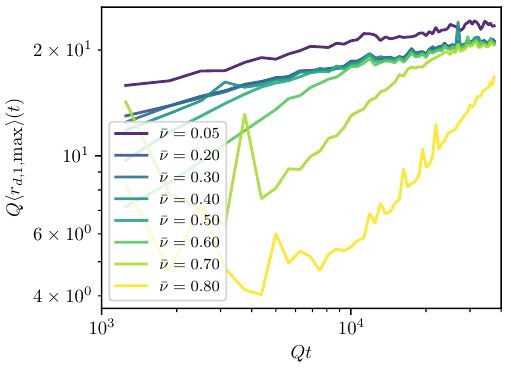
Figure 12: The average maximum death radius of 1-dimensional persistent homology classes varying with time, displayed for ¯ ν -values as